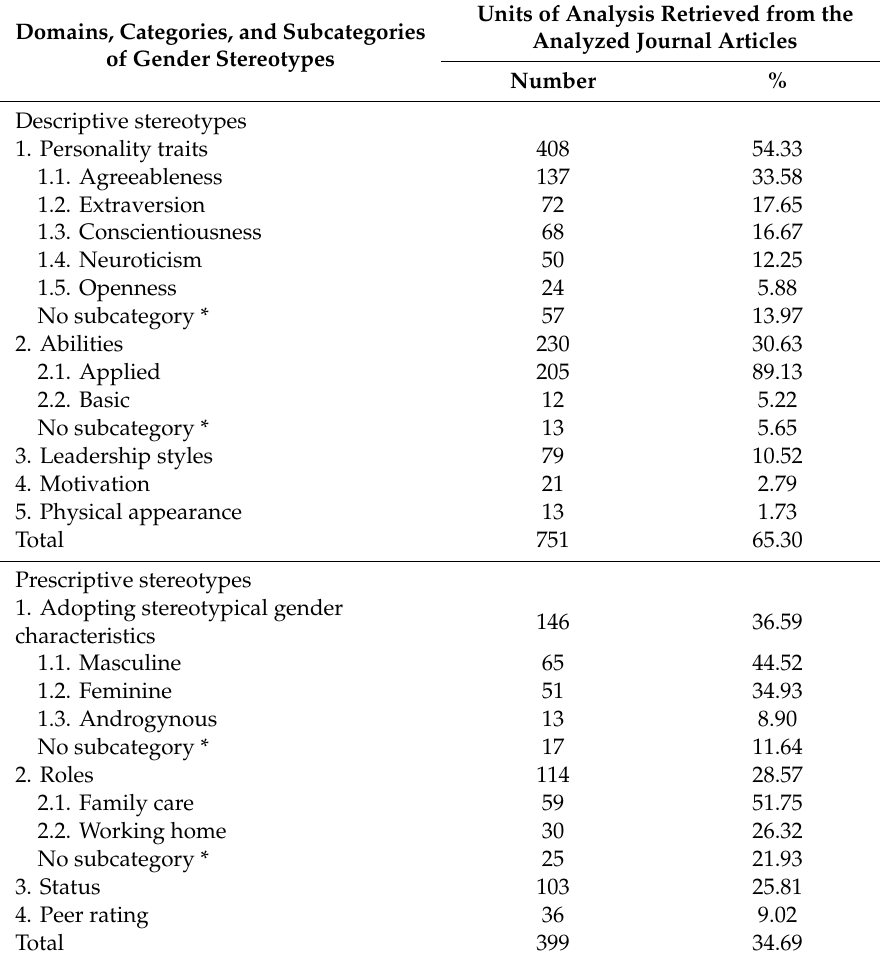
Table 5. Descriptive and prescriptive stereotypes categories